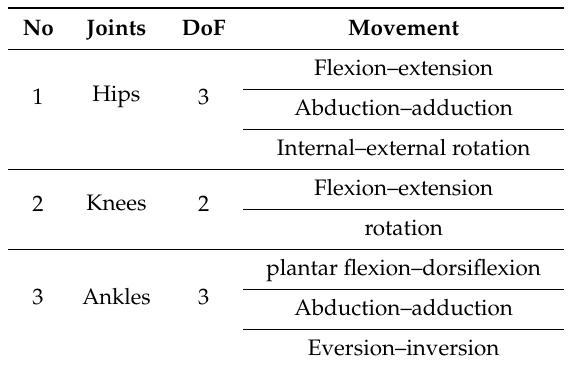
Table 1. Degrees of freedom (DoF) of each joint in the lower